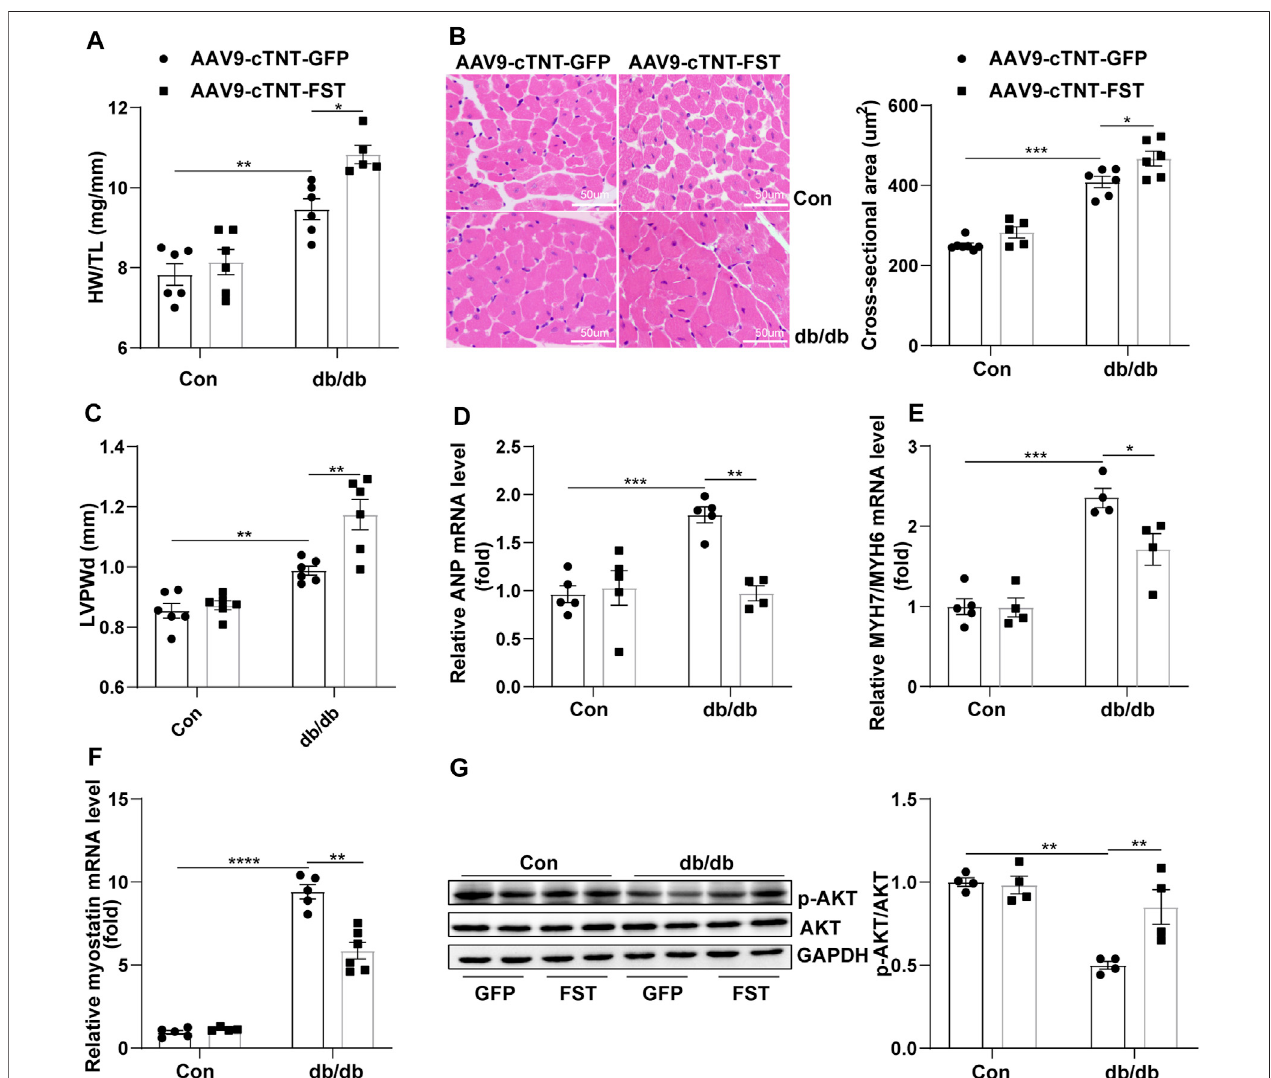
FIGURE 3 | Overexpression of FST is associated with preserved cardiac hypertrophy. The ratio of heart weight/tibia length (HW/TL) of each group [ (A) , n (cid:1) 6]. Representative images of H&E staining and quantitative analysis (magni fi cation: 400 × [ (B) , n ≥ 5]). LVPWd was measured by echocardiography [ (C) , n ≥ 5]. Quantitative real-timePCRanalysisofmRNAtranscriptionofANP,MYH7/MYH6[ (D,E) , n ≥ 4],andmyostatin[ (F) , n ≥ 4]inthemyocardialtissues.Proteinlevelsof p -AKTandAKTand quantitative analysis in heart tissues [ (G) , n (cid:1) 4]. * p < 0.05; ** p < 0.01; *** p < 0.001.